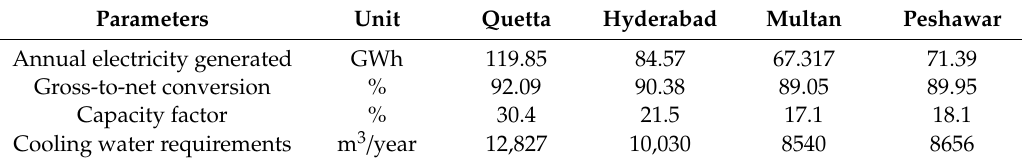
Table 13. Design characteristics and specifications of the PD system.